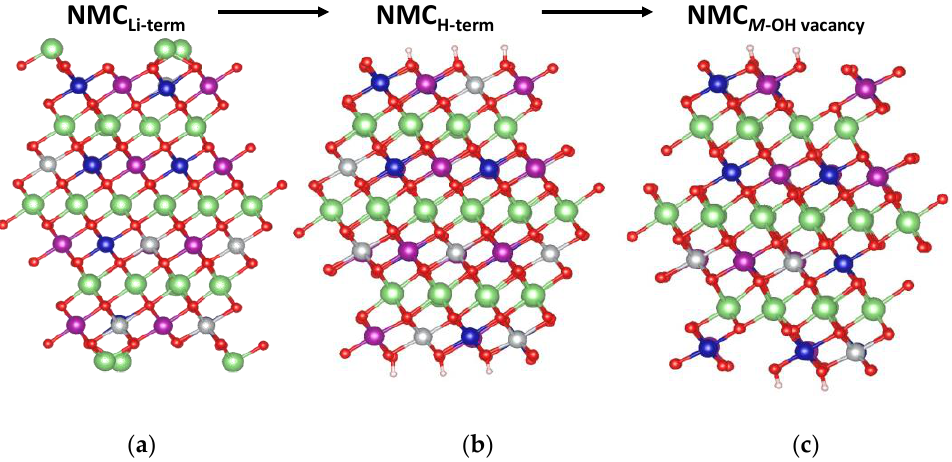
Figure 2. The release of a M -OH unit from the Li(Ni 1/3 Mn 1/3 Co 1/3 )O 2 cathode surface is modeled in three steps. Initially, the cathode is in its operational conditions and is Li terminated (NMC Li-term ). Upon exposure to aqueous environments, there is a quick Li/H exchange on the surface, giving NMC H-term . The last step involves the release of an M − OH group, creating a vacancy on the surface (NMC M -OH vacancy ).